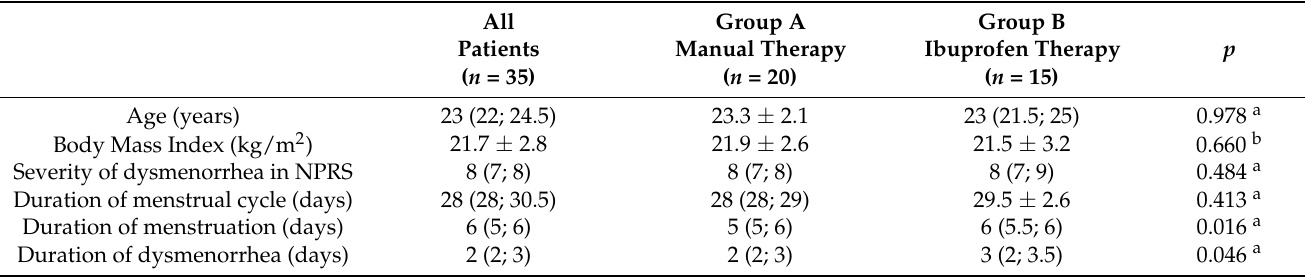
Table 1. Baseline characteristic of women with primary